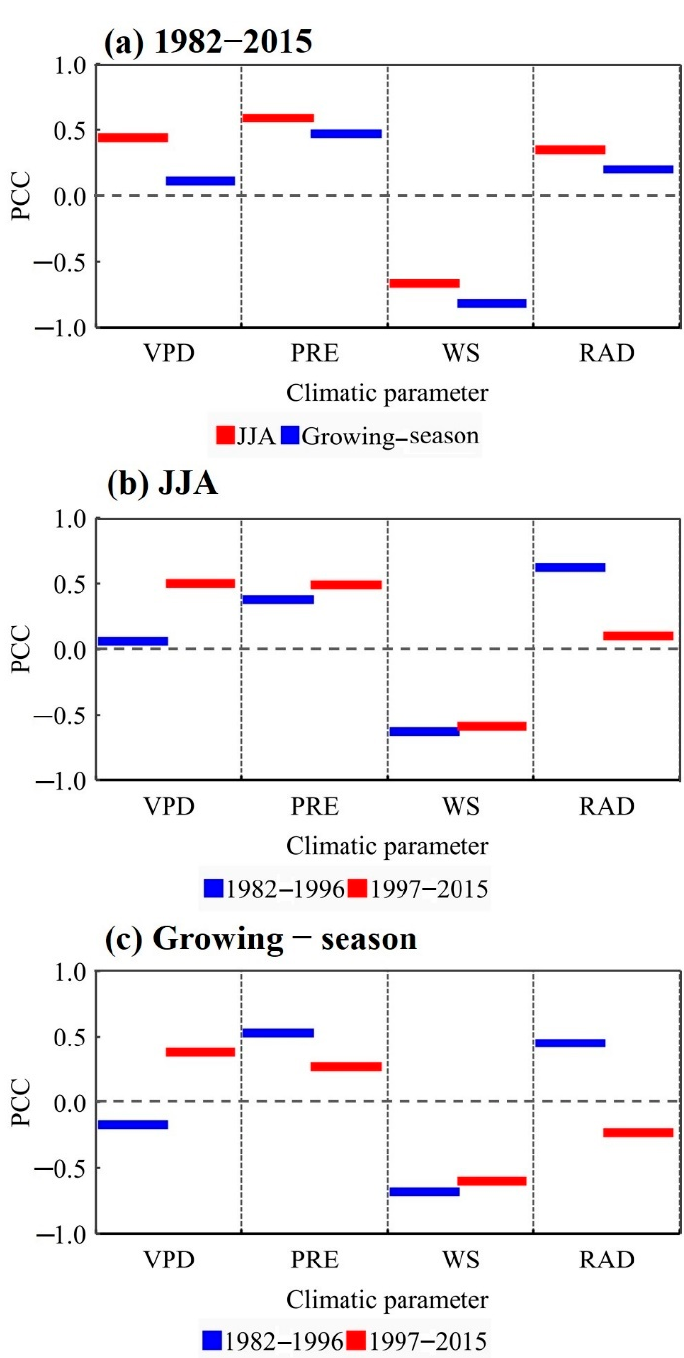
Figure 7. The PCC between NDVI and climate variables over the GS and JJA season during 1982- 2015 ( a ), and comparison of the PCC between NDVI and climate variables over the GS ( b ) and JJA ( c ) season during the two periods of 1982–1996 and 1997–2015.